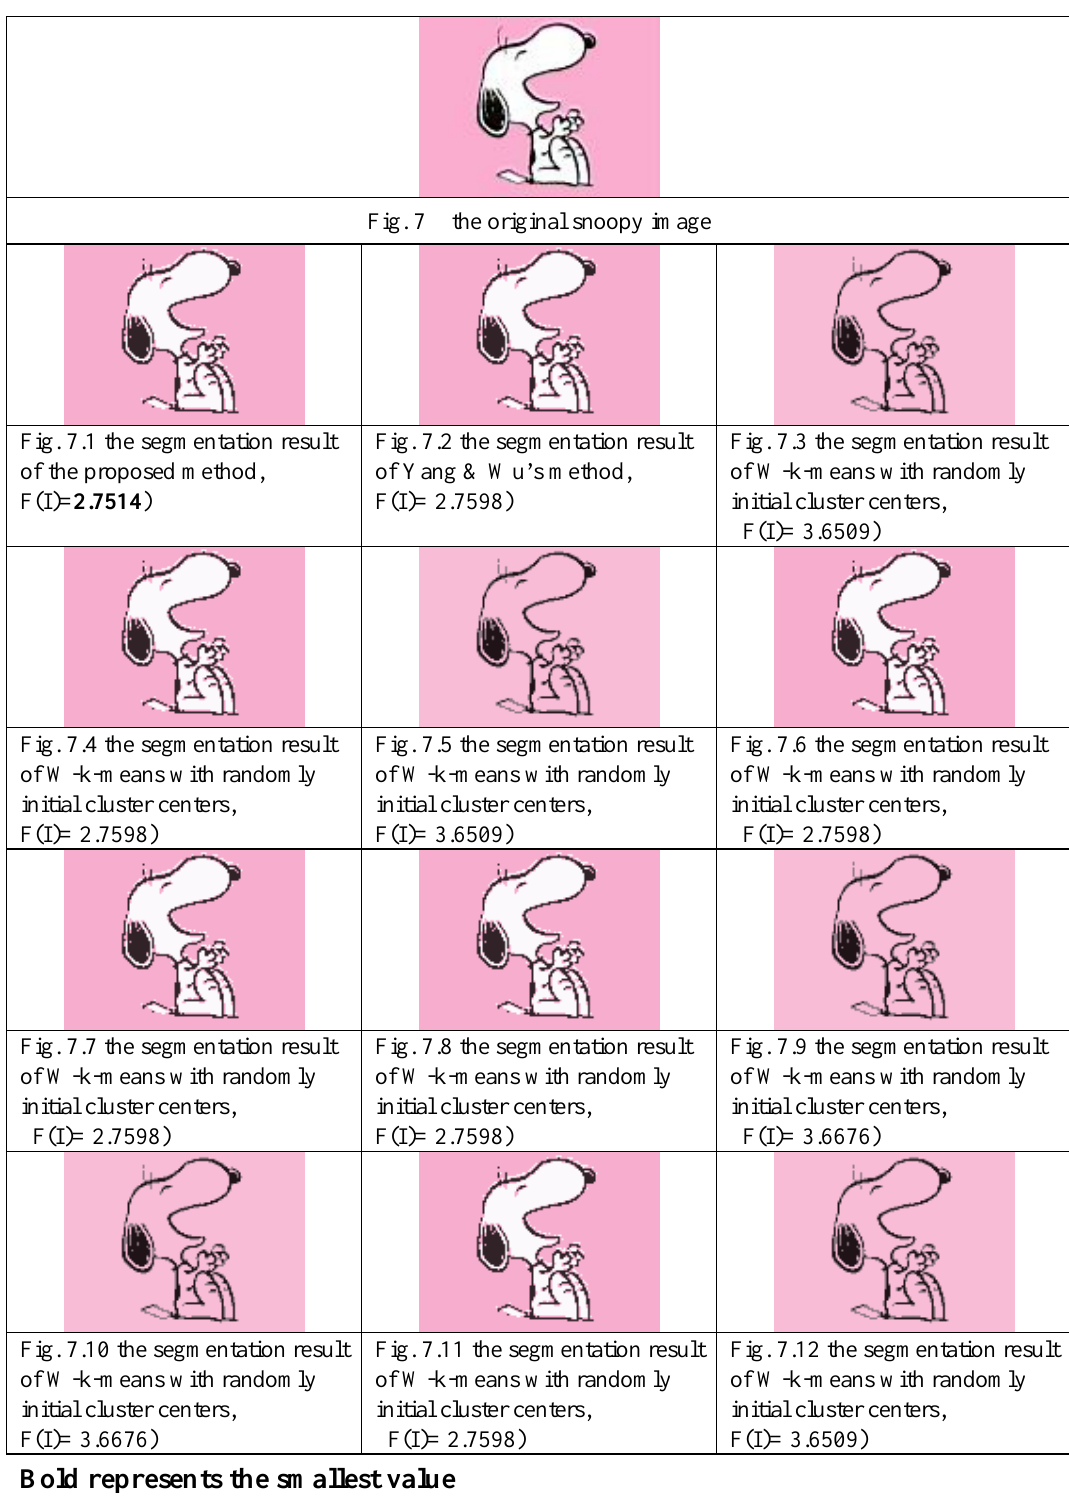
Fig. 7.2 the segmentation result Fig. 7.3 the segmentation result